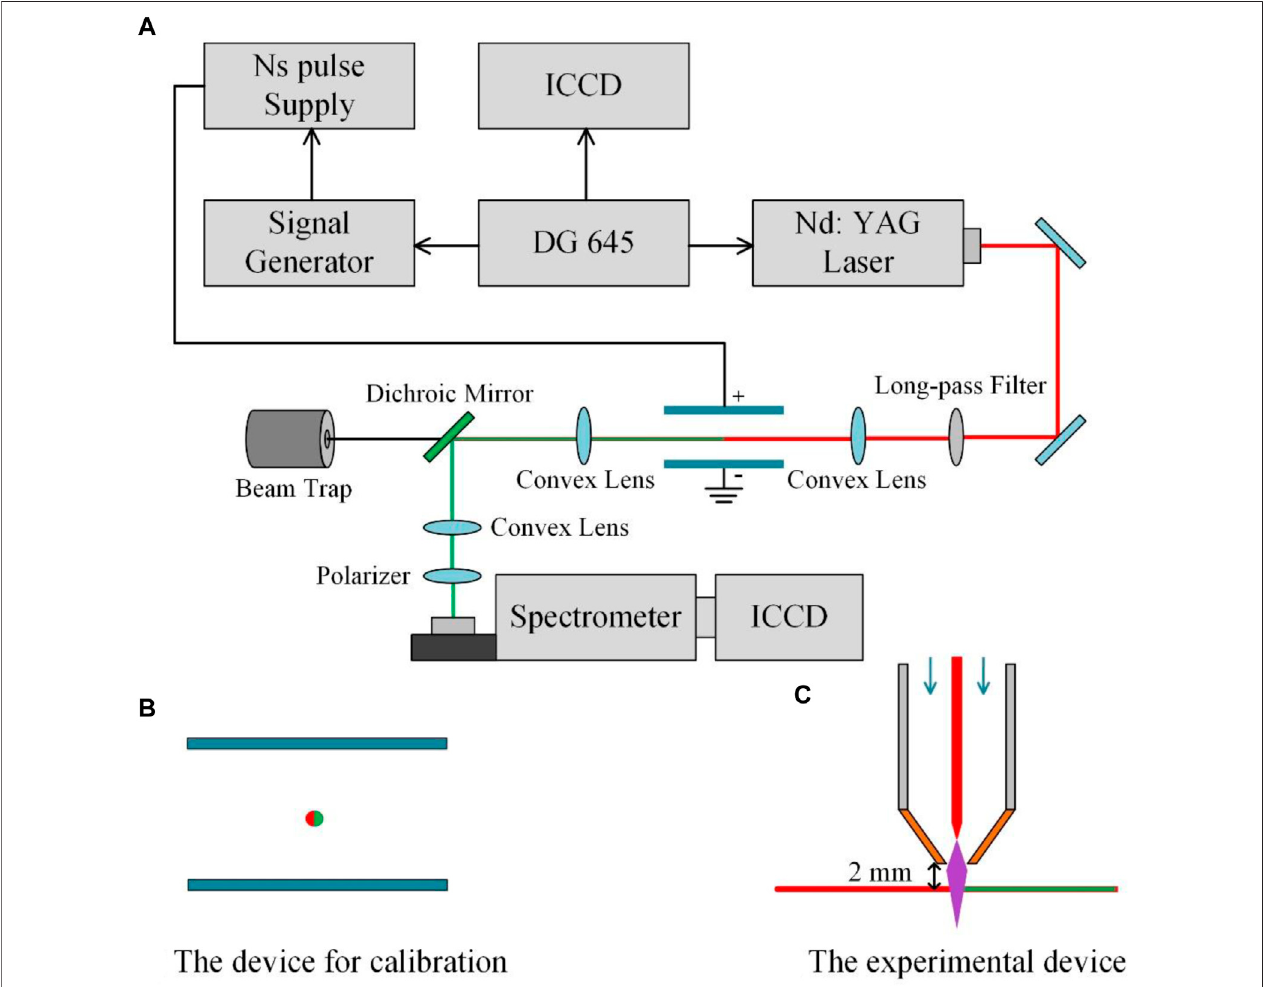
FIGURE 7 | System of E-FISH. (A) Schematic of the apparatus for the electric fi eld – induced second-harmonic. (B) Device for calibration. (C) Experimental device.